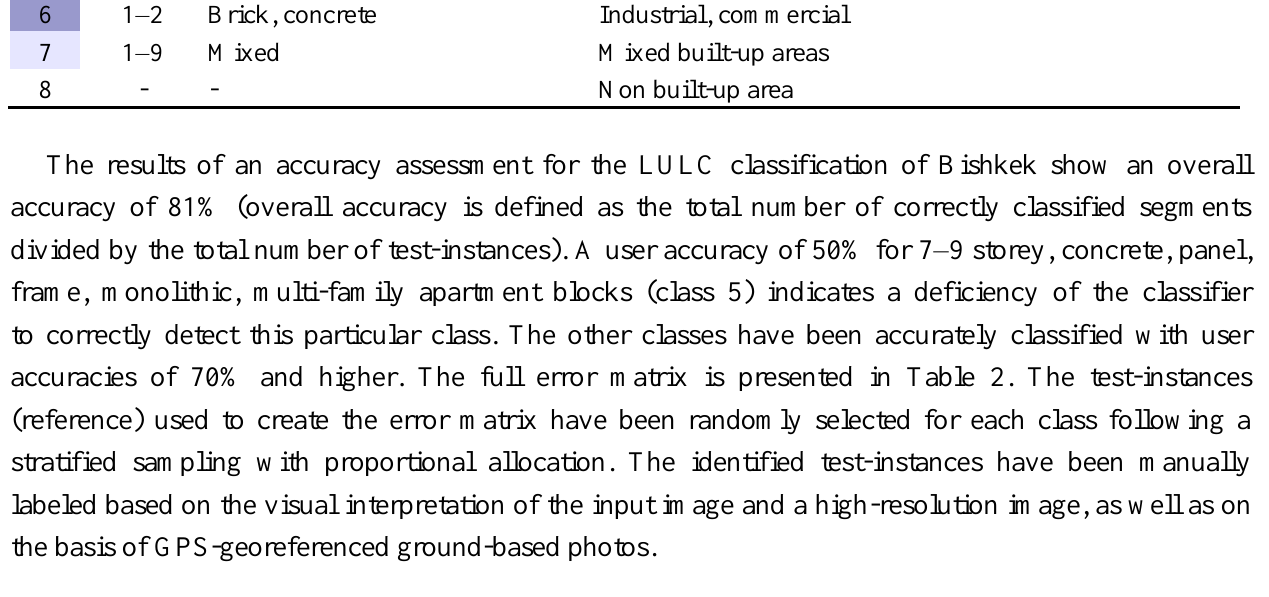
Table 2. Error matrix for LULC classification of Landsat TM (2009). A description of the classes is given in Table